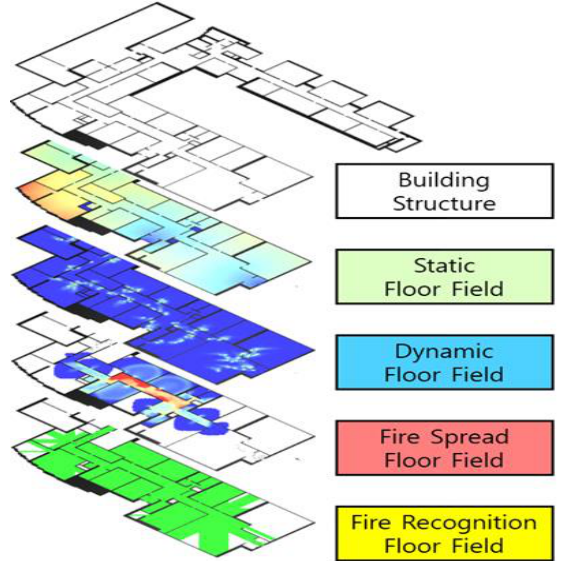
Figure 7. Structure of the improved